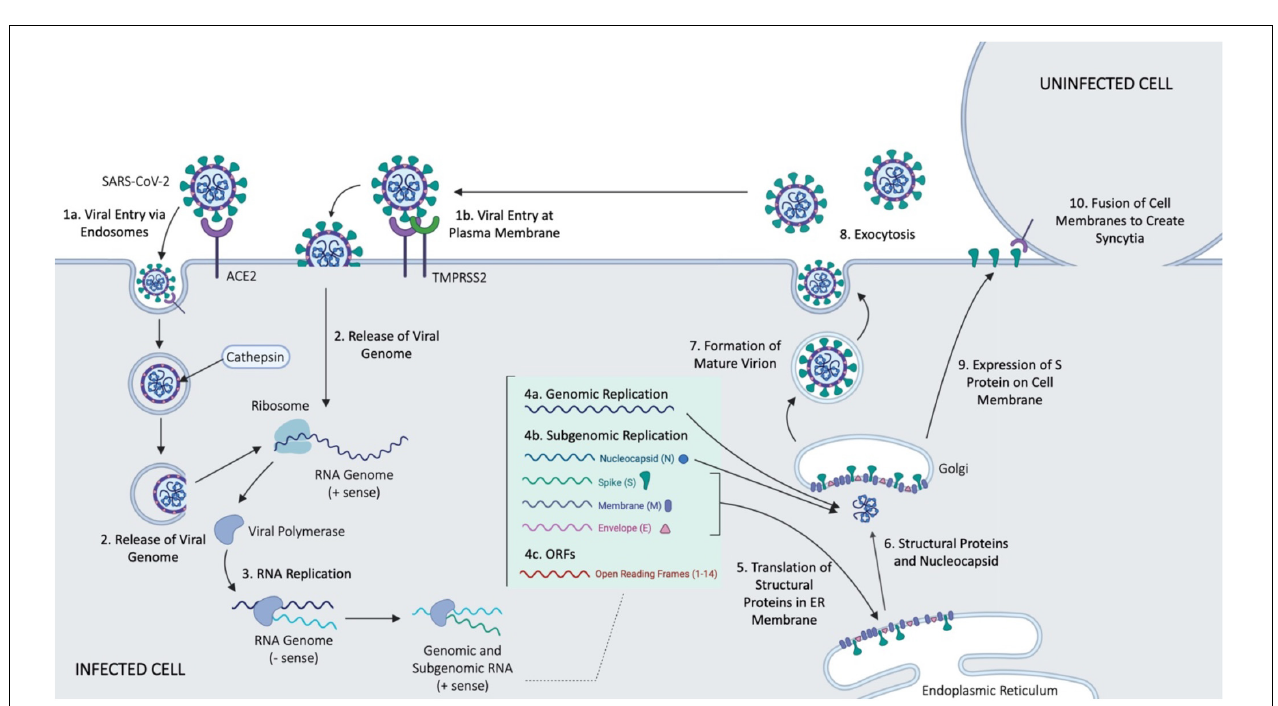
FIGURE 1 | (A) Number of deaths associated with SARS-CoV vs SARS-CoV-2 (as of May 15, 2020). Data from World Health Organization. (B) Number of Pubmed publications on “siRNA and cancer” and “siRNA and SARS” between 2000 and 2010. The relative numbers of published papers in the two field is indicative of relative emphasis of deploying the newly emerging RNAi technology in cancer and SARS CoV infections.